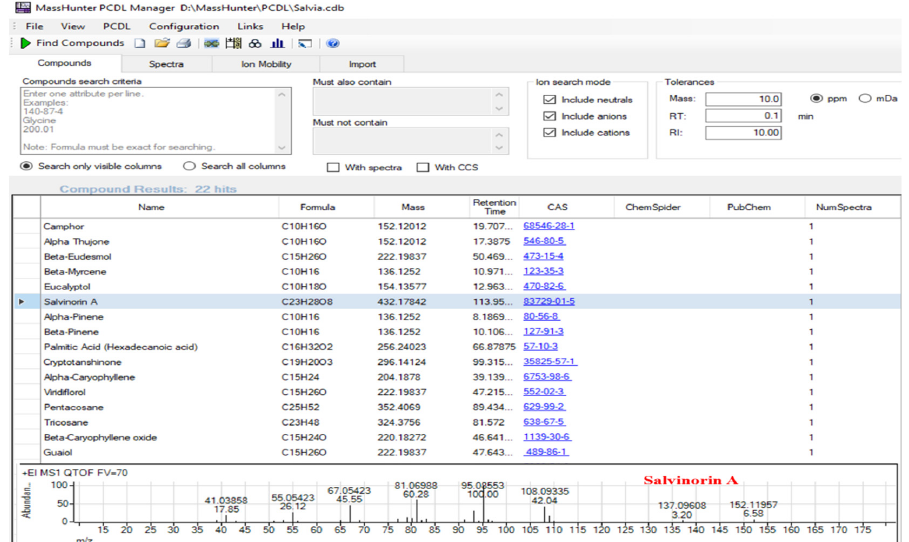
Figure 4. A section of the PCDL showing some of the content available for each entry and the accurate mass EI spectrum of salvinorin A from the PCDL.